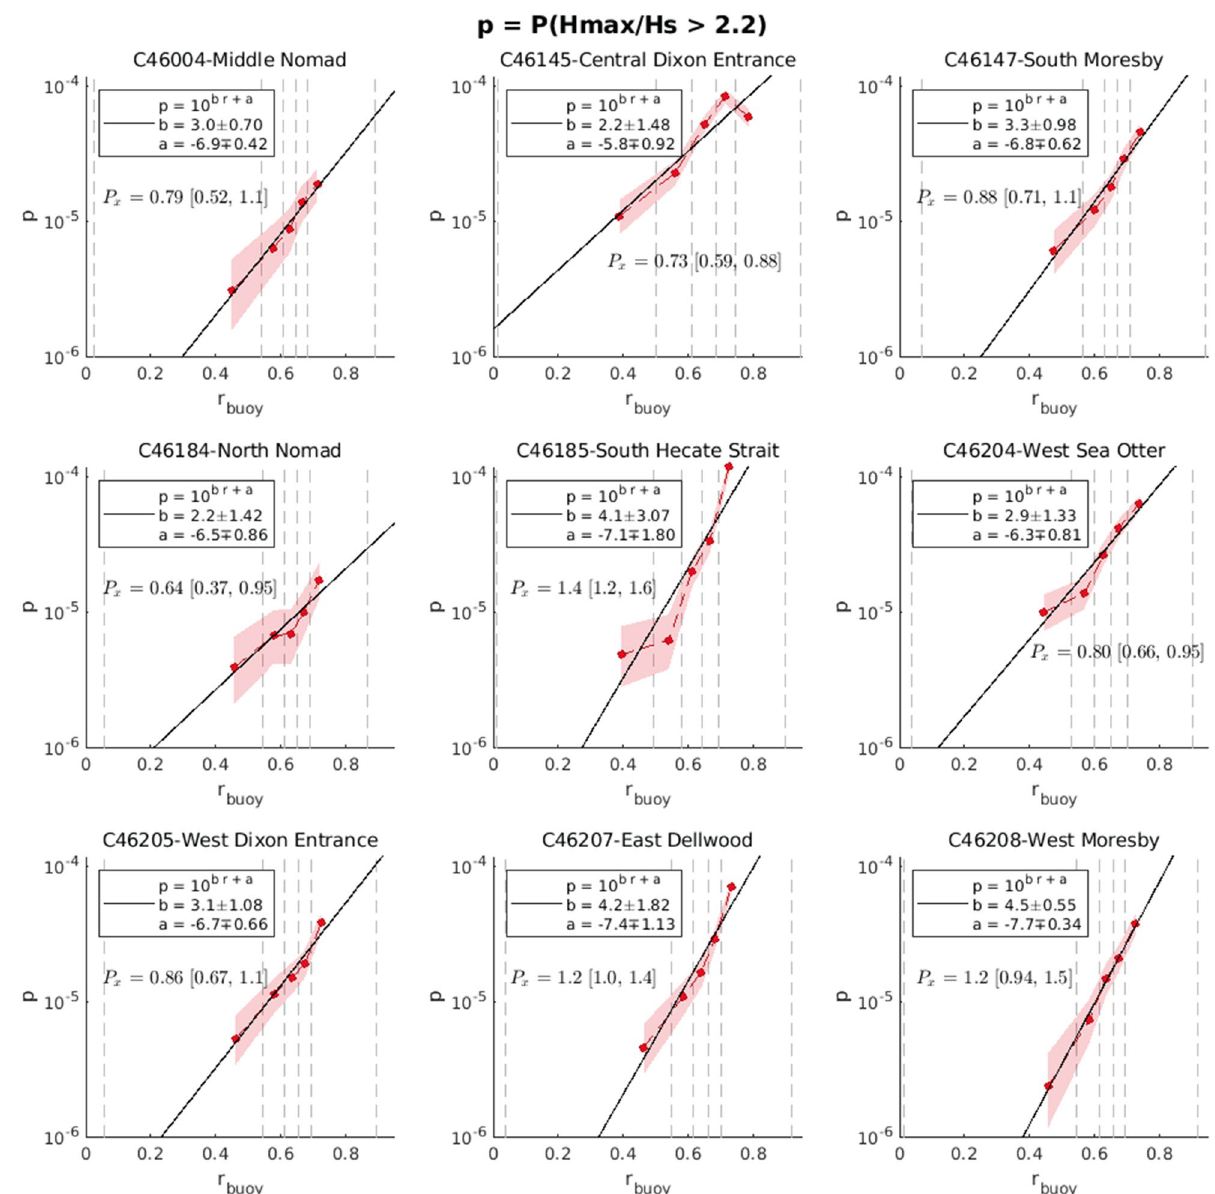
P ( H max / H s > 2.2 ) with observed crest-trough correlation Figure 6. Variation of rogue wave probability p = r buoy from Fisheries and Oceans Canada buoys. Data sets include time series from 2010 to 2021 where quality control was performed and the record appears correct. Shading indicates the 95% credible interval and vertical dashed lines indicates the edges of the parameter